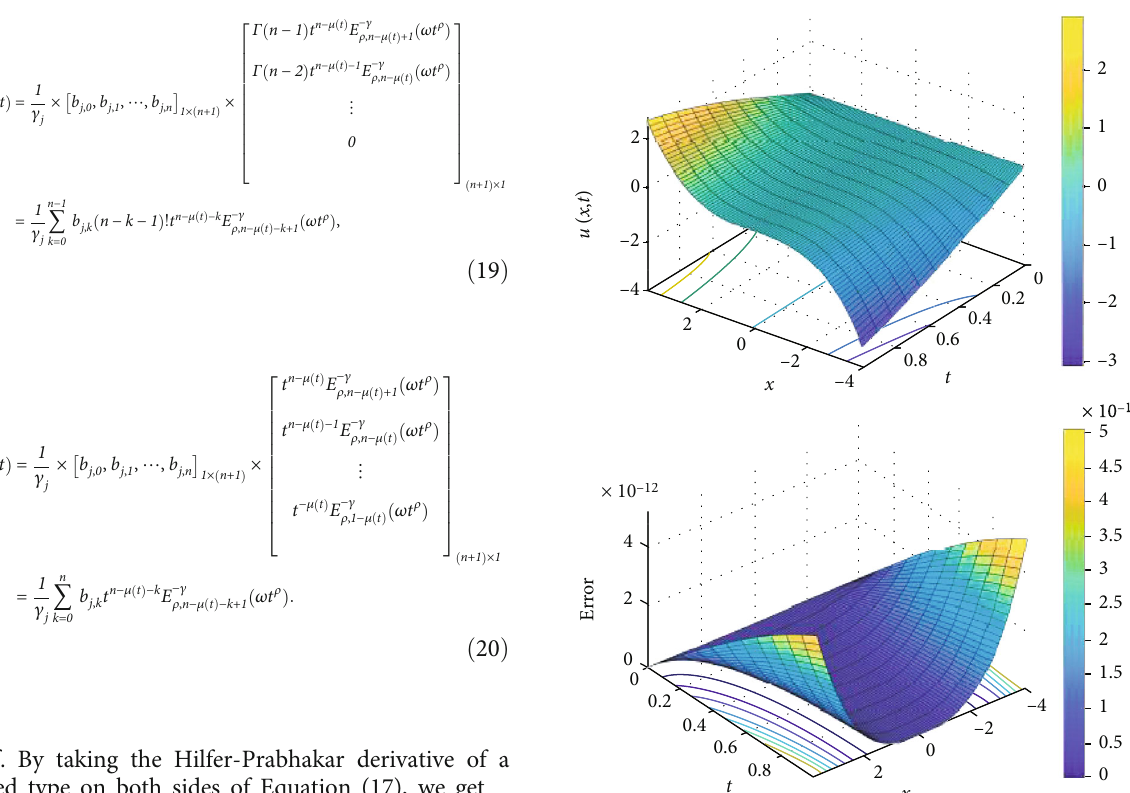
Figure 2: Portrait of the numerical solution and the absolute error for Example 7 with m = 4, n = 10